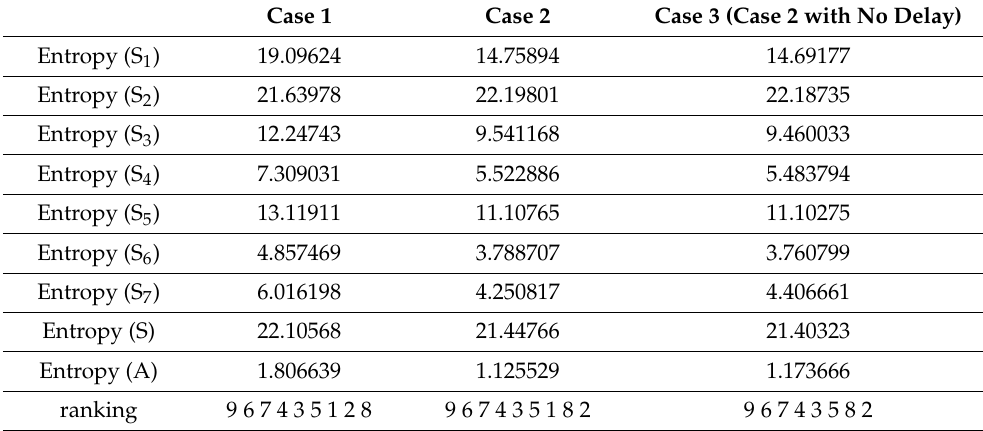
Table 6. Entropy results of the system for all three